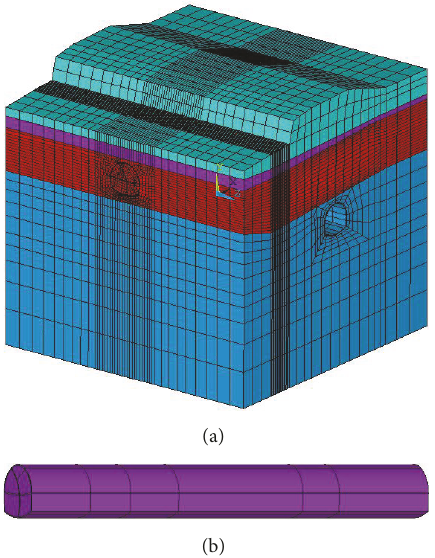
Figure 5: Modeling of KS3 subway tunneling over NBBT ((a) model with elements; (b) volume being excavated in subway